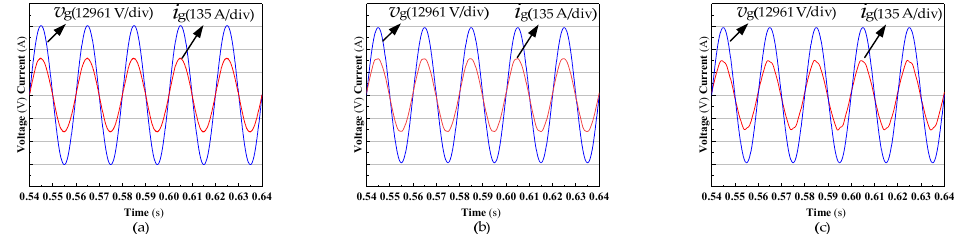
Figure 11. Comparison of simulated fast Fourier transform (FFT) analysis result of secondary-side current (i s 1 ). Figure 12. Simulated waveforms of grid voltage ( v g ) and grid current ( i g ) for: ( a ) IFI-based L-type filter; ( b ) discrete inductor-based LCL-type filter; and ( c ) IFI-based LCL-type filter.